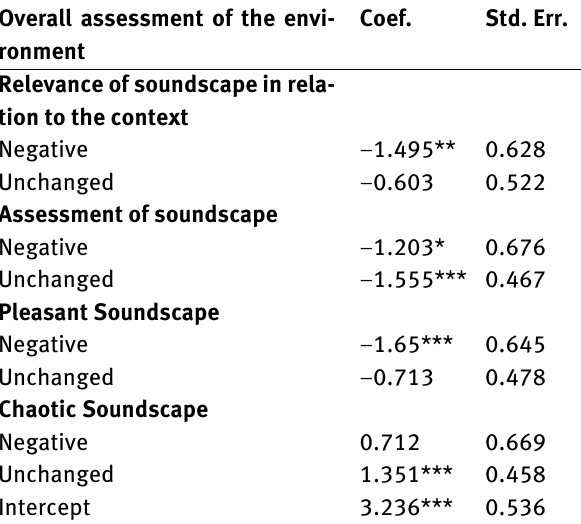
Table 18: Coeflcients of the model for the neighbourhood sounds Neighbourhood Sounds Coef. Std. Err.